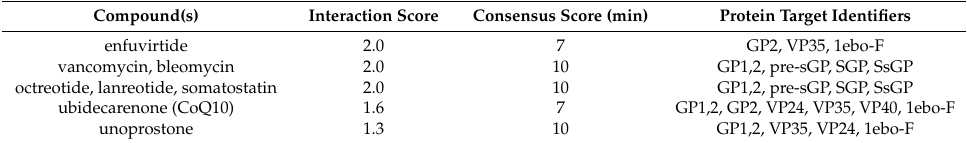
Table 1. Selected top ranked drug candidates against Ebola generated by the CANDO